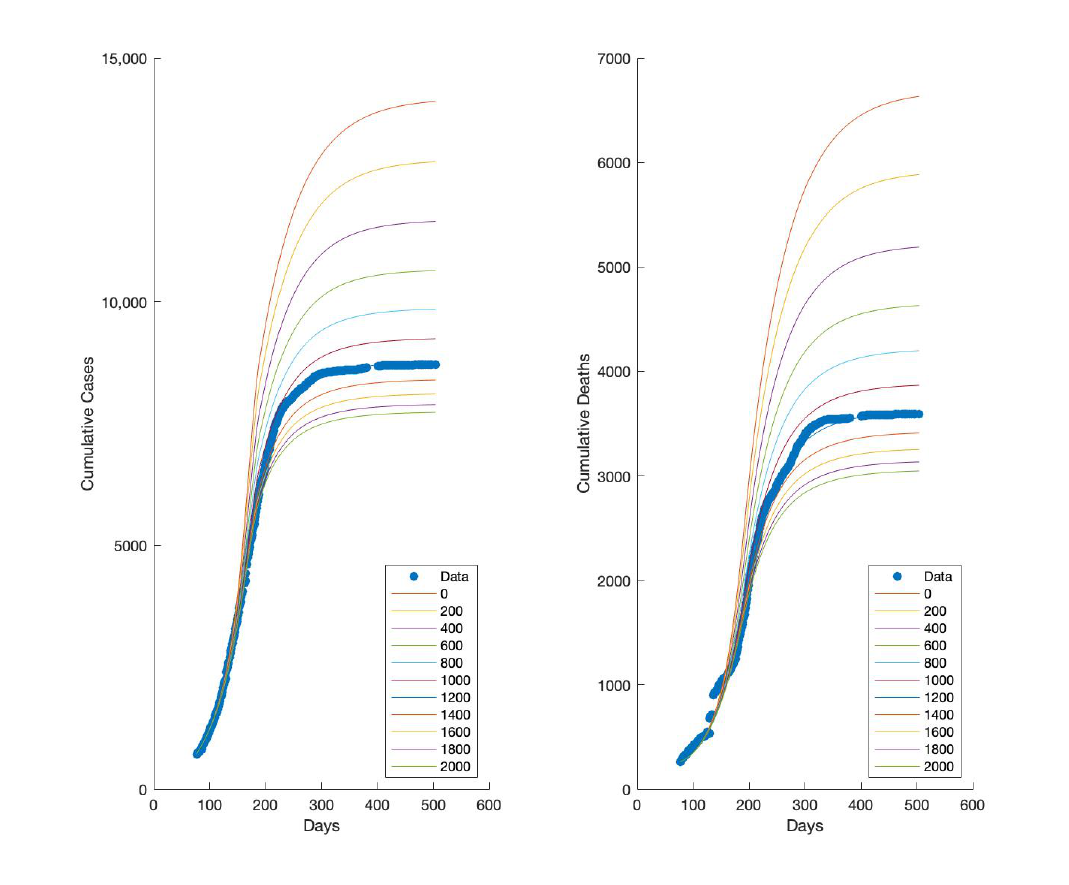
Figure 5. Effect of varying the number of contact tracers available from 0 to 2000, with 1200 as the corresponding number in our